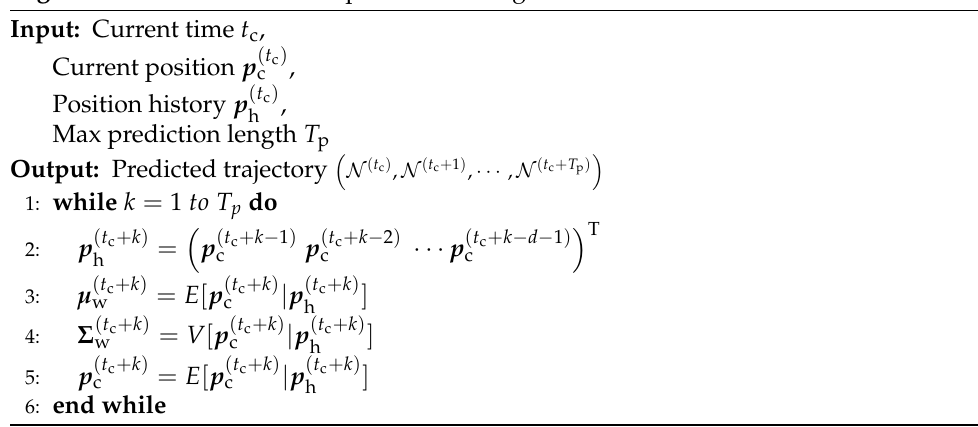
Algorithm 2 Worker’s motion prediction using GMR